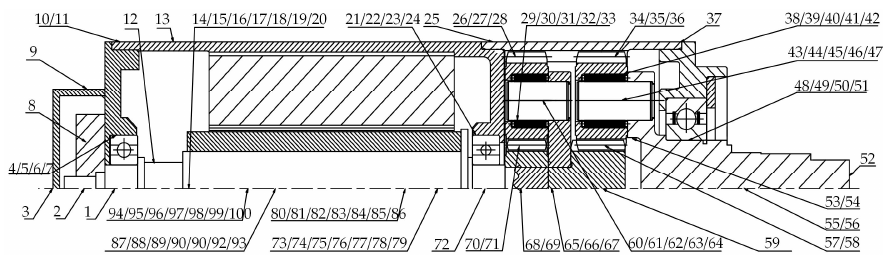
Figure 2. Node partition of the driving component.